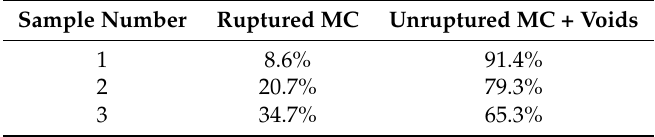
Figure 13. 3D reconstructed images of the segmented raw data showing the crack (blue), microcapsules (yellow) and cement (grey); ( a ) a selected section of fractured cement paste in the vicinity of the crack; ( b ) a top-down view of crack surface. Ruptured microcapsules are indicated by a black square box. The scale bar is 1 mm for both images. Table 1. Trigger ratio microcapsules along the crack of cement paste with a diameter (1) 400–600; (2) 200–400; and (3) 50–200 µ